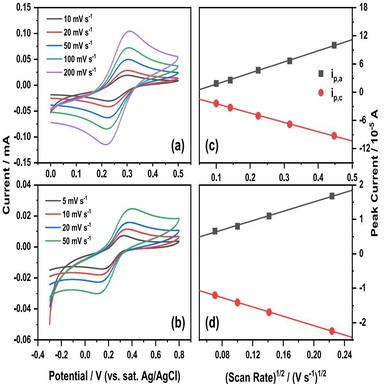
Determination of the electrochemical active surface area of GCE and BC-GCE. (A) CV curve of different scan rates of GCE in K3 solution; (b) CV curves of different scan rates of BC-GCE in K3 solution; (c) The linear fitting of CV peak current of GCE in K3 solution to the square root of scan rate; (d) The linear fitting of CV peak current of BC-GCE in K3 solution to the square root of scan rate.